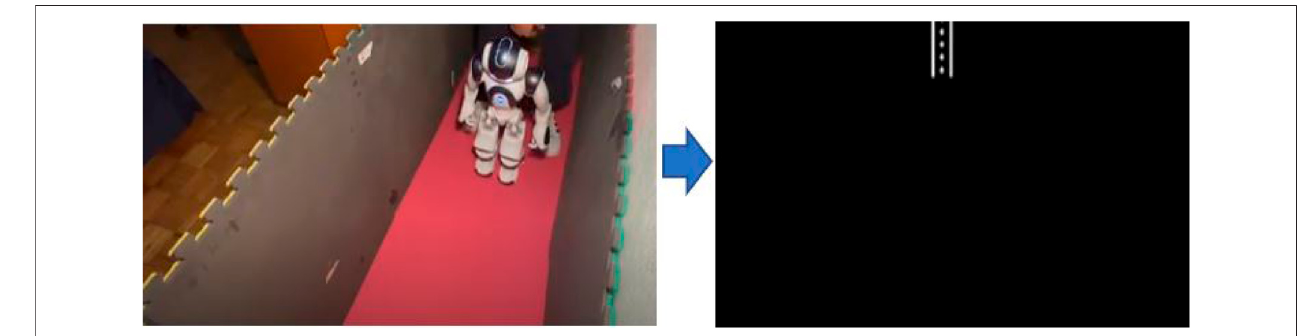
FIGURE 9 | Test: straight path.